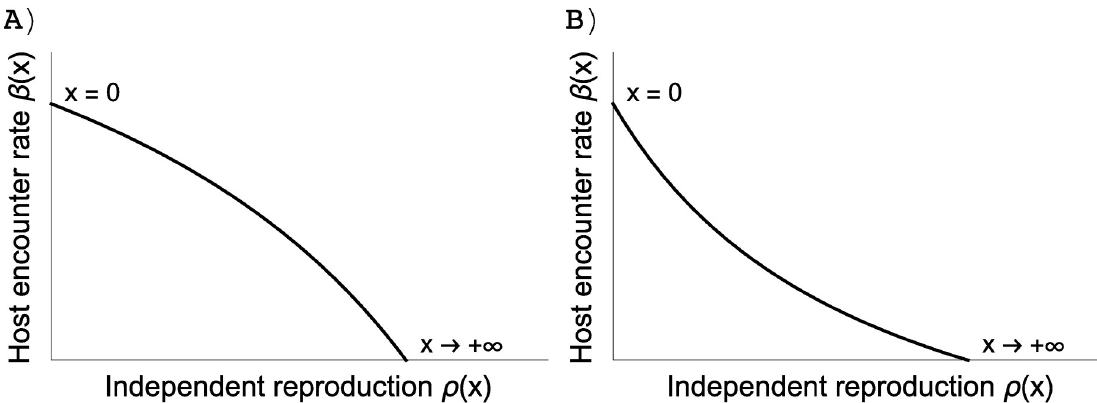
Fig 2. Relationship between β and ρ , which is derived from the assumption that increasing the investment x in independent reproduction ρ ( x ) leads to a reduction in host encounter rate β ( x ). Host encounter rate and independent reproduction are functions of the investment such that β ( x ) = β max /( α x + 1); ρ ( x ) = ωx /( δ x + 1). Depending on the parameters, the resulting trade-off can be convex (A) α = 0.7, δ = 1.3 or concave (B) α = 3.1, δ = 1.3. A convex trade-off curve indicates that investing in host encounter rate does not reduce much reproduction rate, whereas a concave trade-off curve indicates the